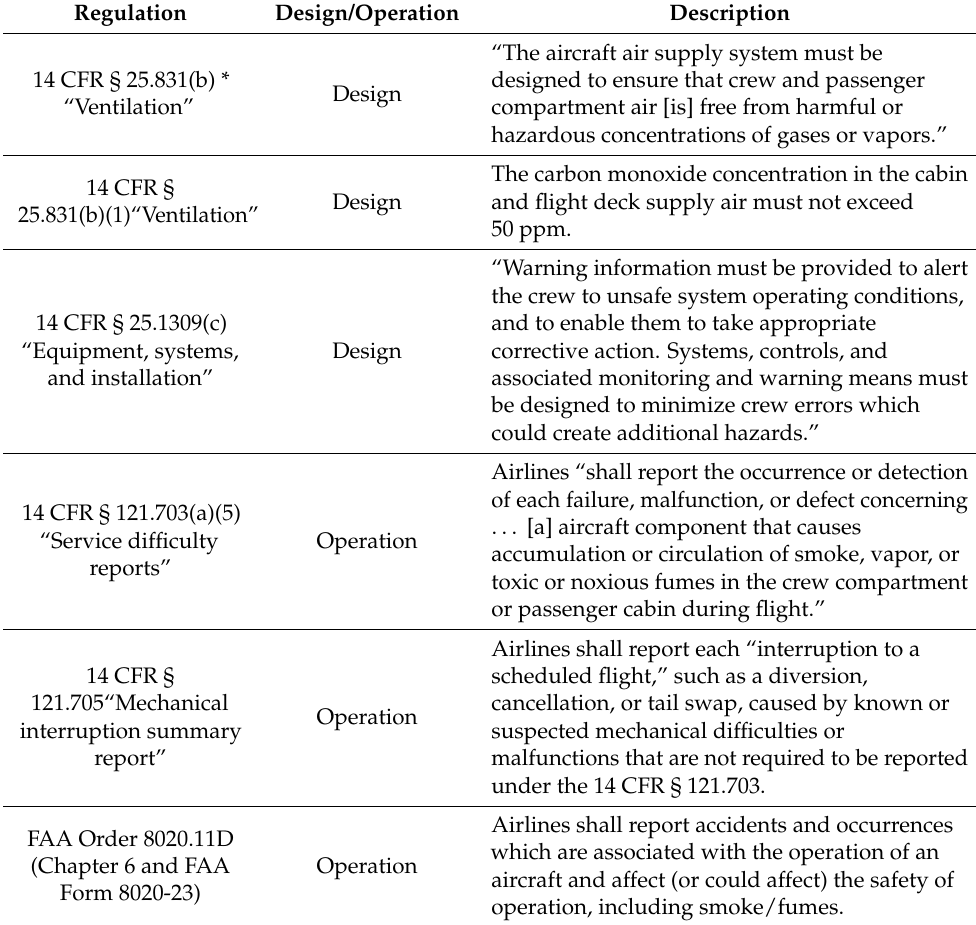
Table 4. U.S. aviation regulations relevant to air quality on routine commercial